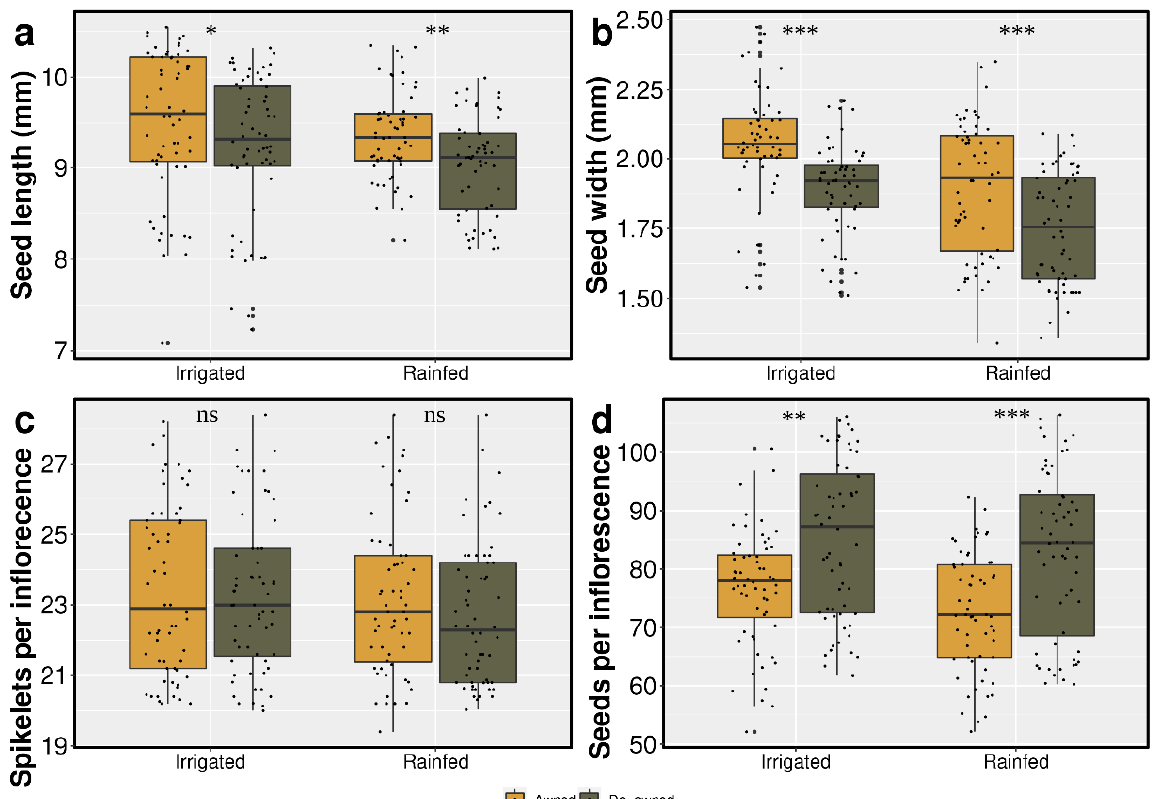
Figure 3. Box plots of seed length ( a ), seed width ( b ), spikelets per inflorescence ( c ), and seeds per inflorescence ( d ), and significance levels of difference between control and awn excision. ns: not significant, * p <0.05, ** p <0.01, *** p <0.001. Each box plot denotes the average of 10 accessions for corresponding traits. The significances indicate the comprehensive effect of awn excision on different traits of 10 Siberian wildrye accessions.